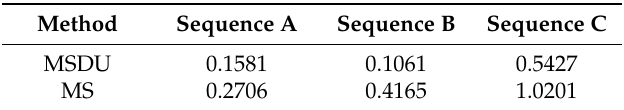
Figure 11. Graphs of the target tracking error. ( a – c ) show, respectively, the comparative statistics for the tracking error produced by MSDU and MS for Sequences A, B and C. Table 3. Quantitative evaluation of moving target tracking by MSDU and MS. The values shown are the values of the average tracking error for each sequence.